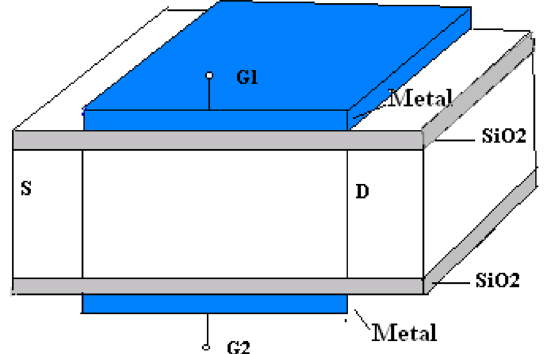
Fig. 2 Schematic of the Double-Gate MOSFET [14] (S: Source, D: Drain, G and G : Gate-1 and gate-2, SiO 1 2